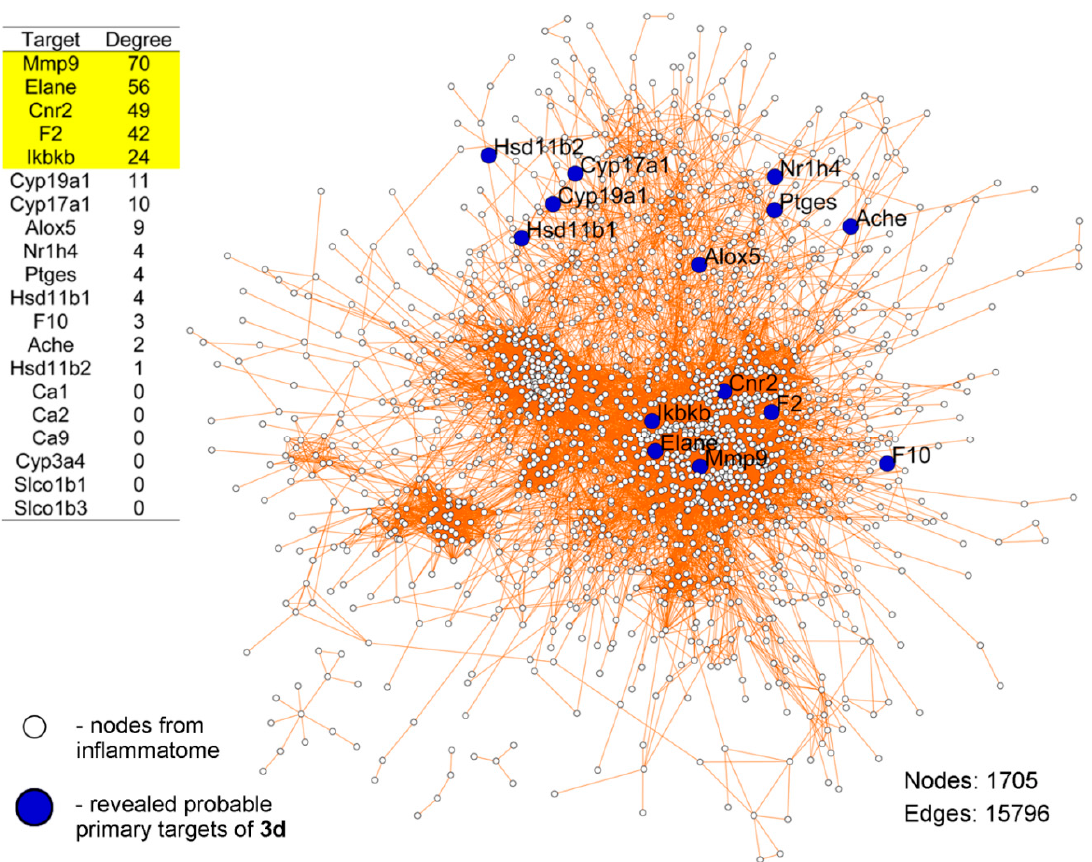
Figure 7. Probable primary protein targets of compound 3d and their association with inflammatory response in mice. Probable targets of 3d listed in a table were predicted using Naïve–Bayes machine learning together with nearest neighbor (NN) search in Polypharmacology Browser 2.0. The protein–protein interaction network was reconstructed with rodent inflammatome-associated genes and revealed probable targets of 3d by using the Search Tool for Retrieval of Interacting Genes/Proteins (STRING) database (confidence score ≥ 0.7) in Cytoscape.